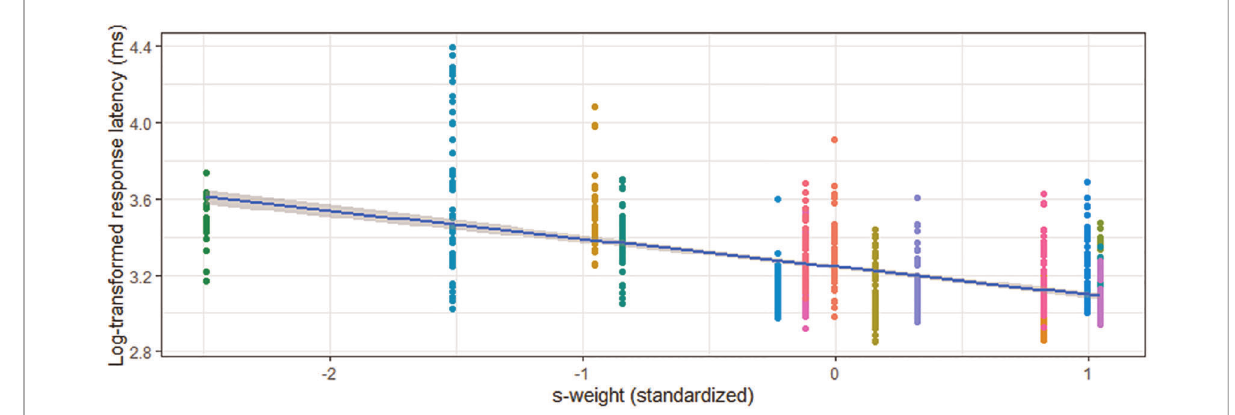
FIGURE 4 Relationship between s-weight (standardized) and rWPVT semantic trial response latency (log-transformed) across participants (represented by different colors).